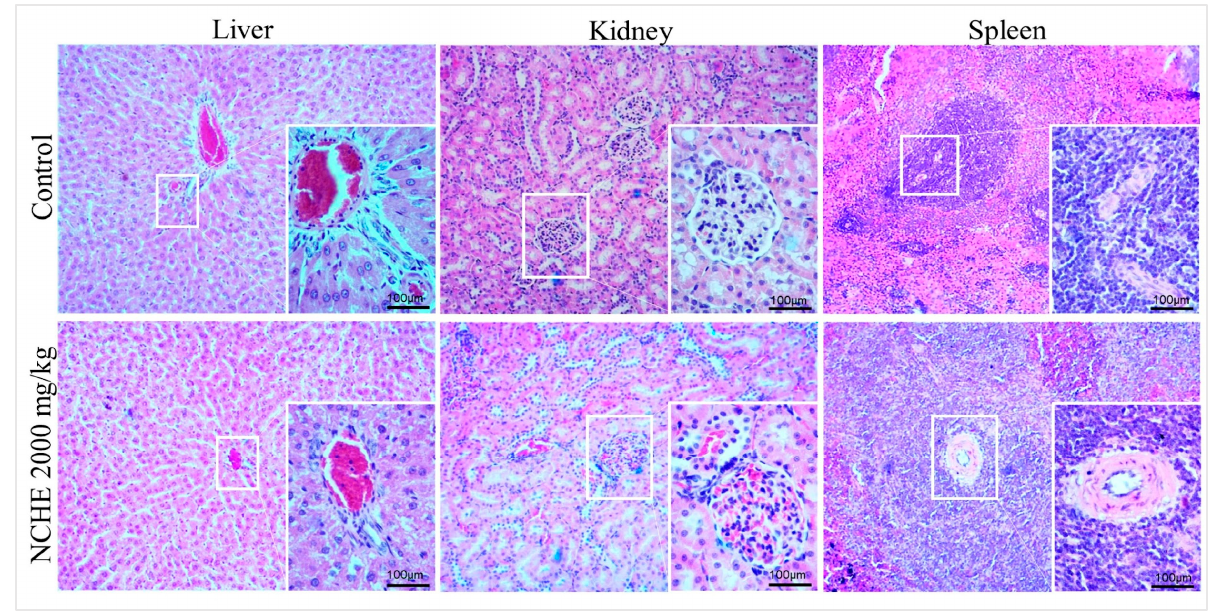
Figure 2. Photomicrographs of histopathological analyses of the liver, kidneys and spleen (eosin- hematoxylin stain; 10 × and 40 × magnification) of tissues from rats in the control group and treated with N. cochenillifera hydroethanolic extract (NCHE) in a single oral dose (2000 mg/kg) after 14 days.